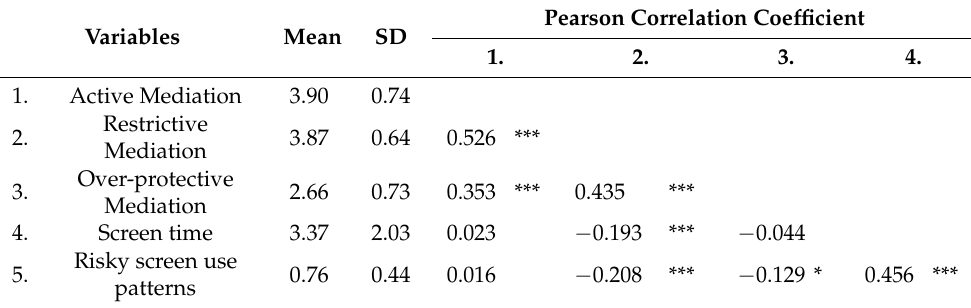
Table 5. Means, Standard Deviations, and Pearson Correlation Coefficients for MEPA-20 Scores, Screen Time, and Risky Screen Use